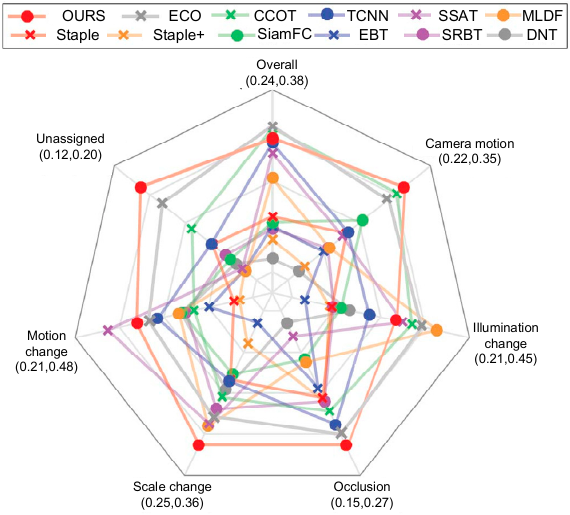
Figure 6. Expected averaged overlap performance on different visual attributes on the VOT2016 benchmark. The proposed method and the top performing trackers from VOT2106 are shown. The visual attribute axes are shown below the attribute labels.